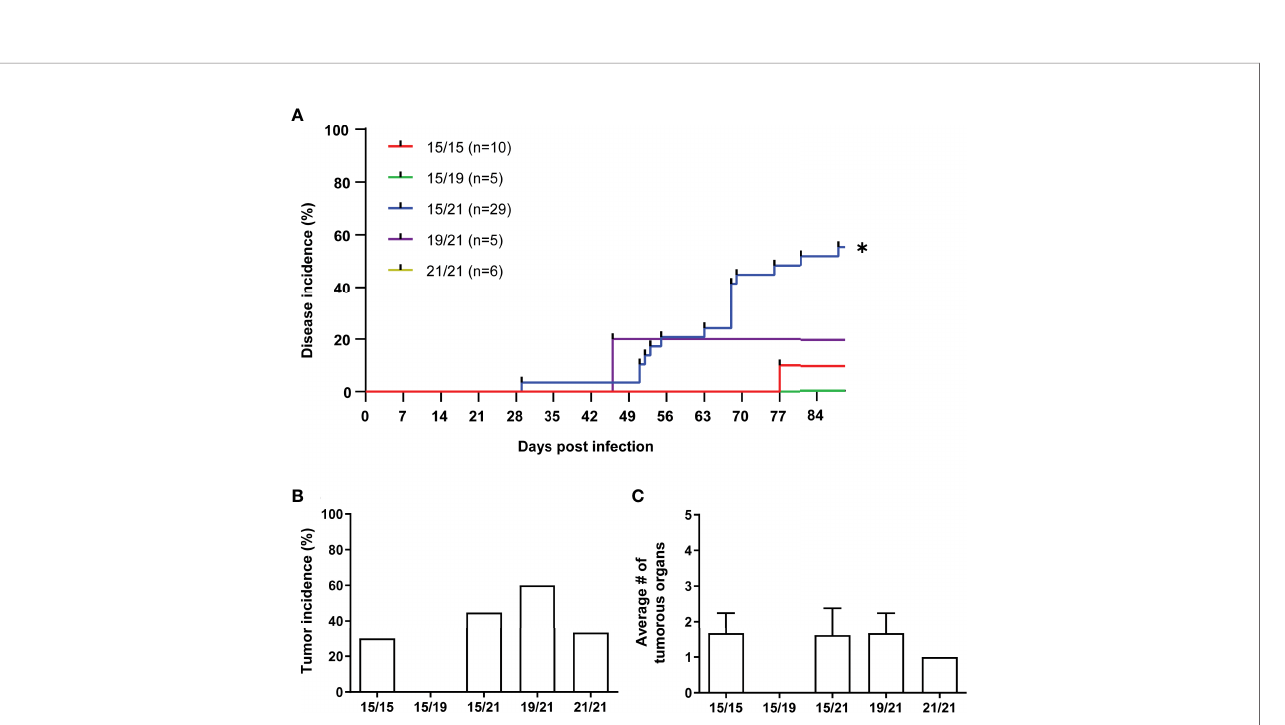
FIGURE 3 | (A) Kaplan-Meier analysis of Marek ’ s disease incidence in contact chickens with different MHC haplotypes (*p ≤ 0.5, Mantel – Cox test; n=55). (B) Tumor incidences in contact chickens with different MHC haplotypes as percentage of chickens with macroscopic tumors (n.s., Chi-square test; n=55). (C) Mean number of affected organs harboring gross tumors per contact chicken (n.s., Kruskal-Wallis test with a Dunn ’ s multiple comparison post-hoc test; n=21).